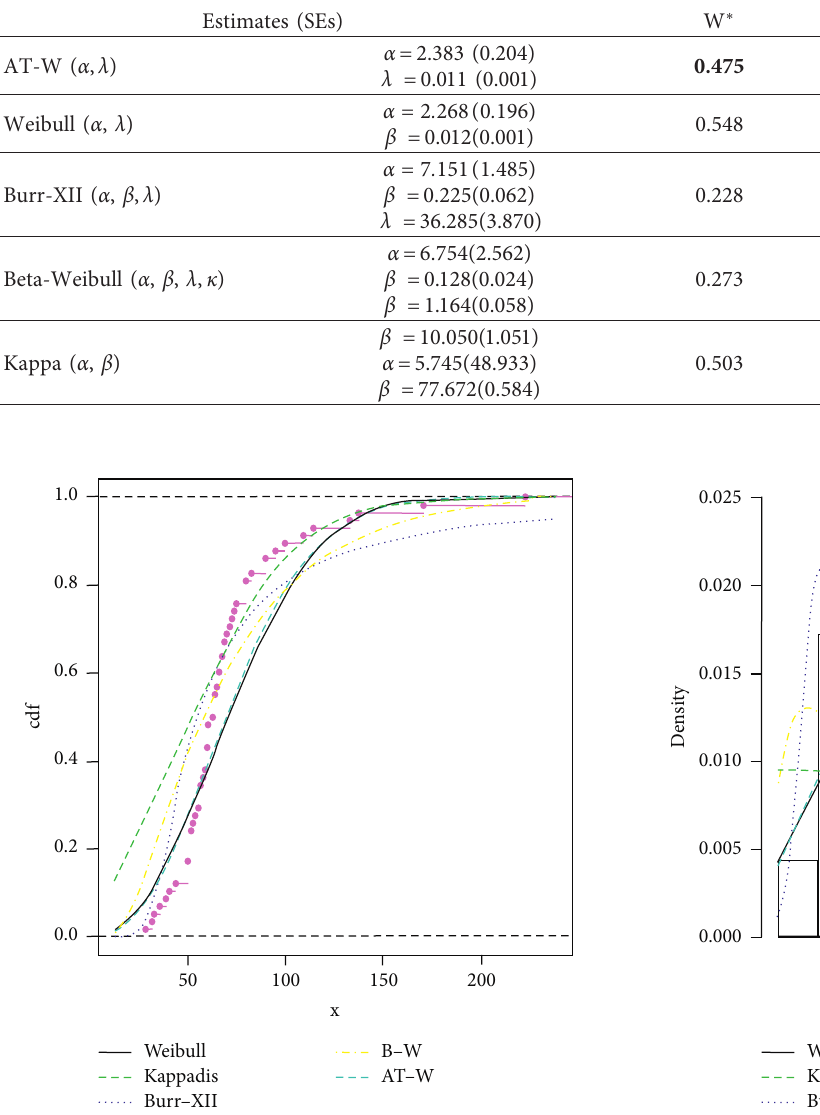
Figure 9: Visual display for the estimated pdf of the competing